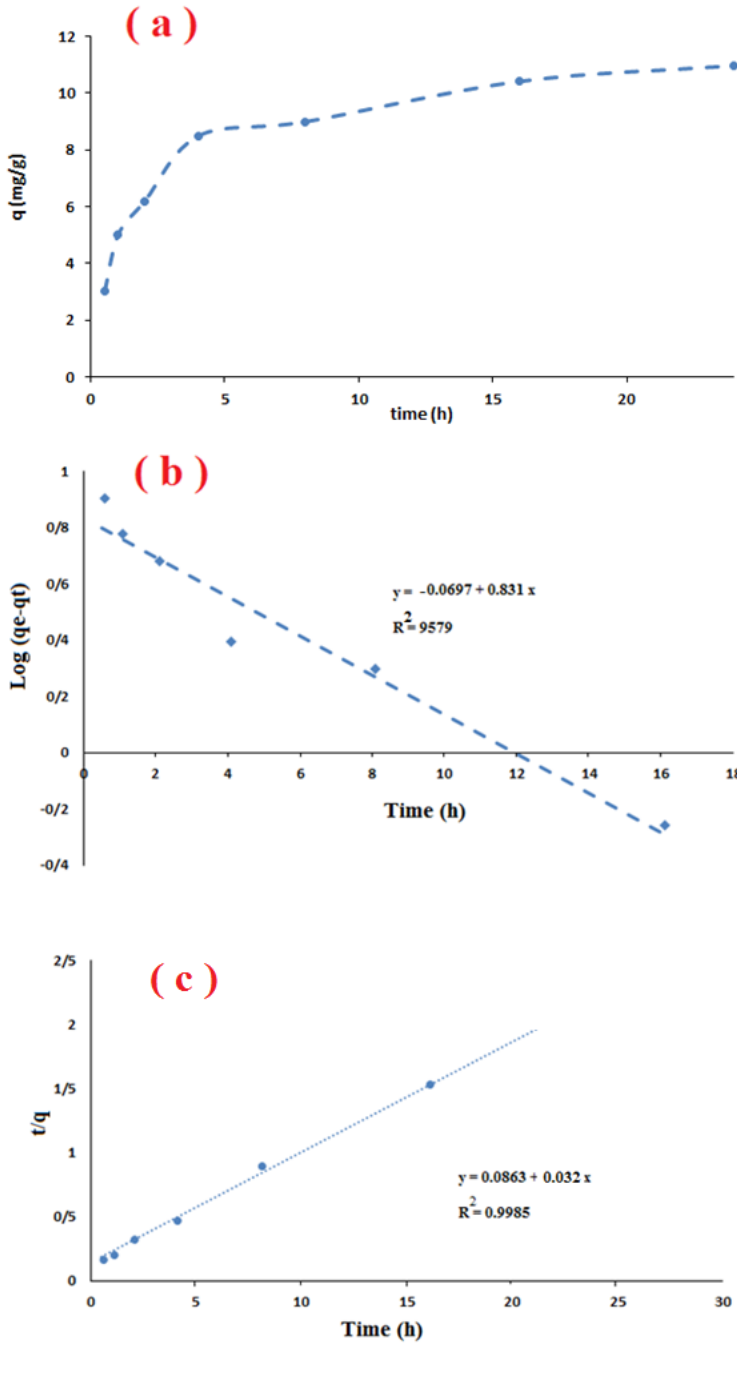
Fig. 5, (a) The plot of q versus t(h) of F - adsorption on Al-Mn-Ce oxide (Ci=25.0 mg g -1 , T= 298 K), (b) Pseudo first-order kinetic e model, (c) Pseudo second-order kinetics fit for F-